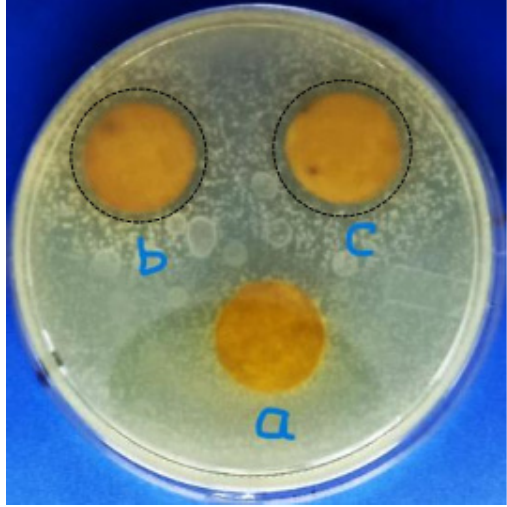
Figure 8. Photograph of the antibacterial activities of ( a ) untreated Batik fabric, ( b ) treated Batik fabric at pH 10, ( c ) treated Batik fabric at pH 11. The black dashed circles are guides for the eye and represent inhibition zones. The diameter of the samples are 17 mm.